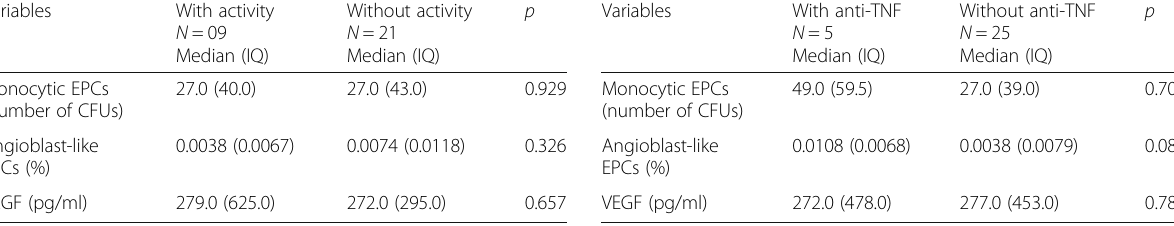
Table 3 EPCs and VEGF in Takayasu ’ s arteritis patients with and without disease activity Variables